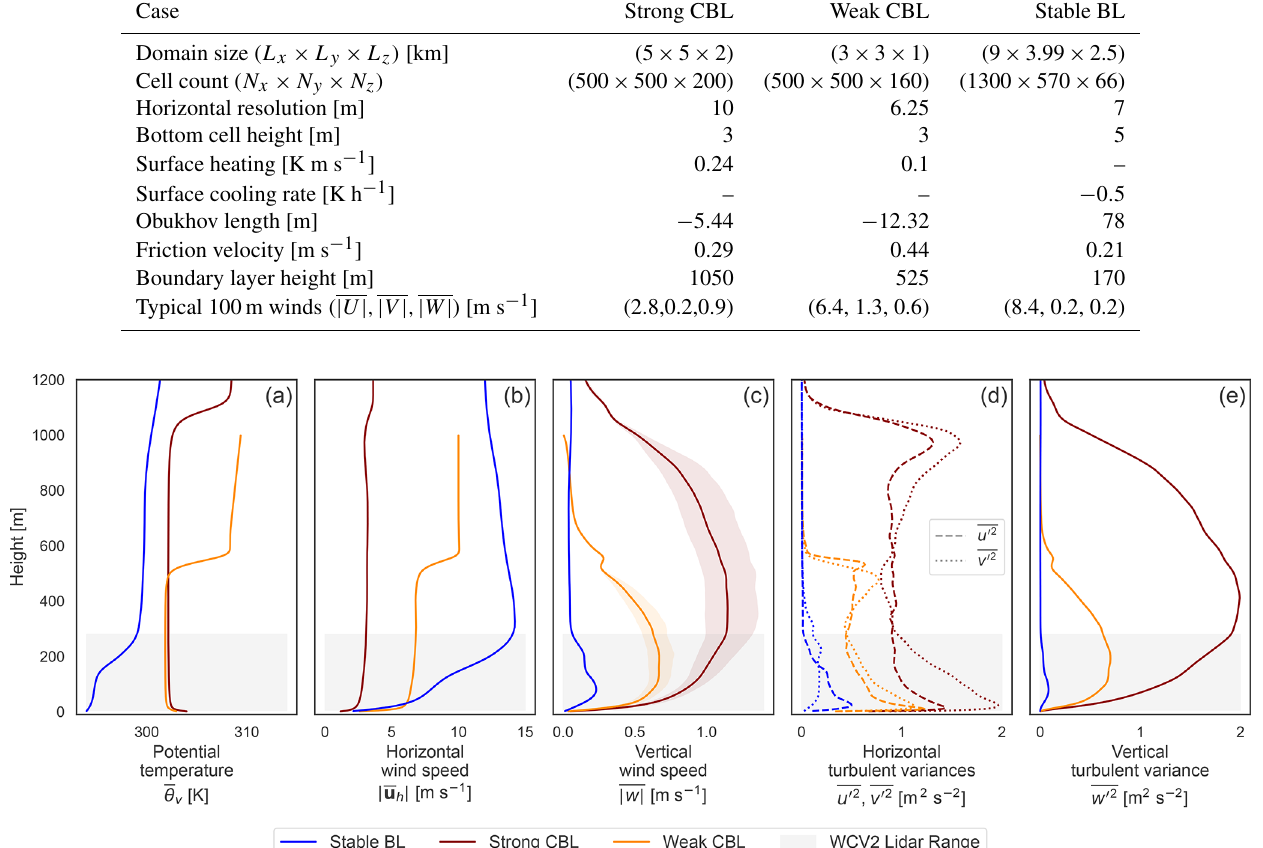
Figure 3. For each of the idealized LES cases, mean profiles of (a) virtual potential temperature, (b) horizontal wind speed, and (c) mean vertical velocity magnitudes with shaded color indicating the span between mean negative and positive values are shown. The turbulent velocity variances, u (cid:48) 2 (dashed) and v (cid:48) 2 (dotted), are shown in (d) with w (cid:48) 2 in panel (e) . The grey region demarcates the WindCube V2 vertical range including the region of influence for the range-gate